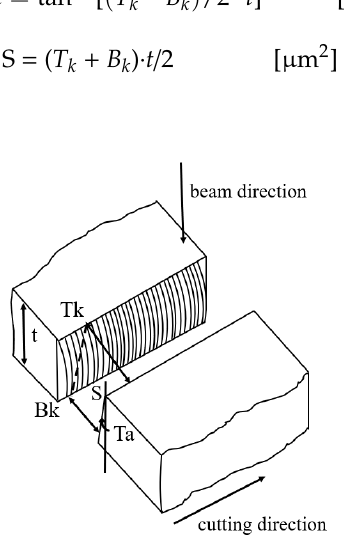
Figure 3. Schematic of kerf geometry.